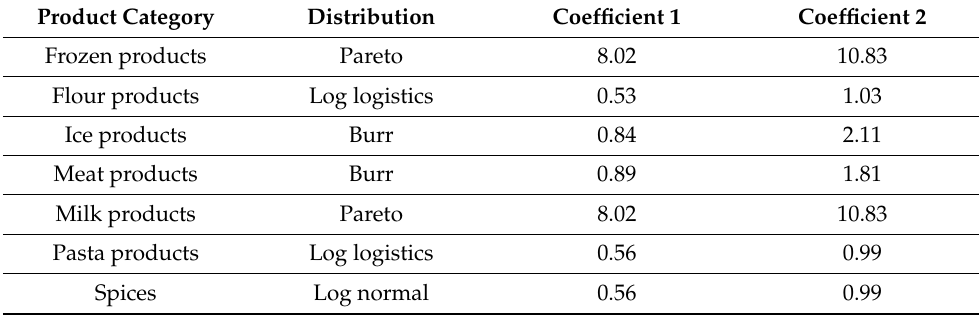
Table 2. Fitted Distribution Functions Based on empirical